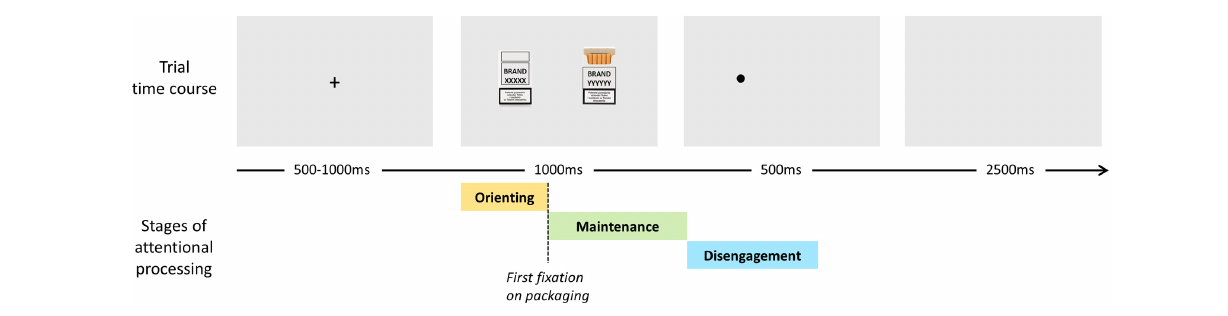
FIGURE 1 | Time course of a dot probe trial and stages of attentional